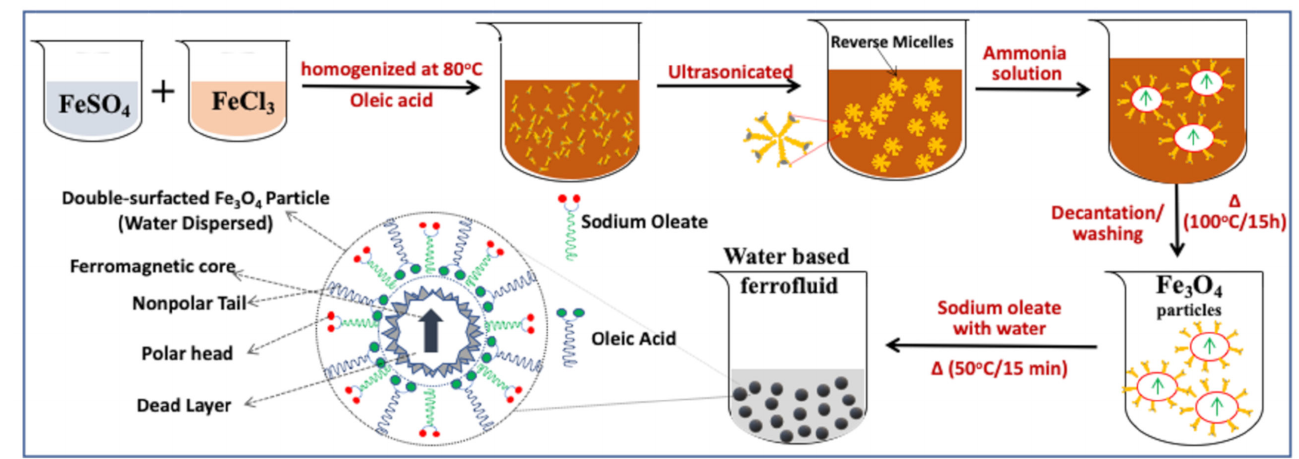
Figure 1. Schematic representation of the aqueous magnetic fluid preparation by dispersing double surfactant (oleic acid (blue string) and sodium oleate (green string)) Fe 3 O 4 magnetic nanoparticles using two-step wet chemical synthesis method (adapted from [20] with permission from Elsevier,